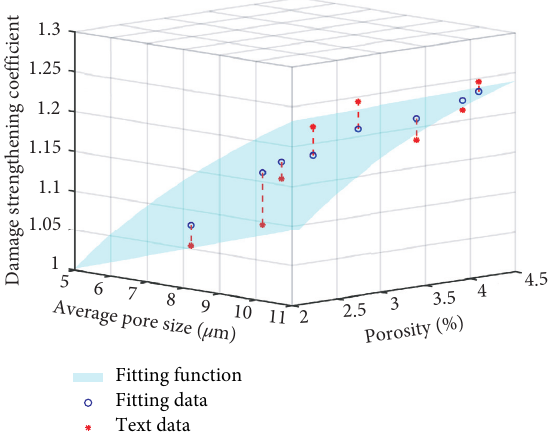
Figure 7: Fitting effect drawing of damage strengthening